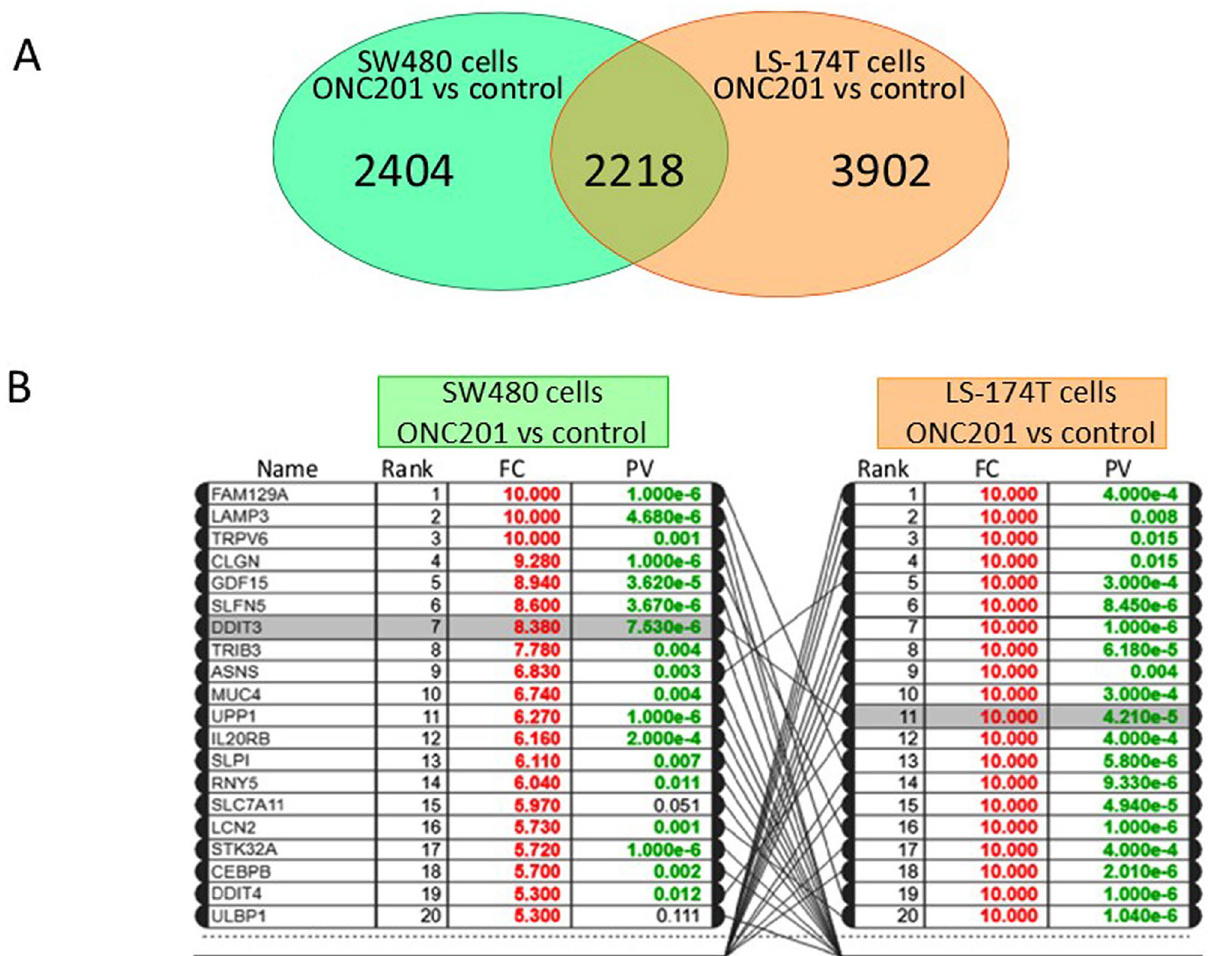
Figure 4. Meta-analysis Alignment of the differentially expressed common genes in response to ONC201 treatment. ( A ) A Venn diagram illustrating the total number of genes perturbed in response to ONC201 treatment in the nonmetastatic and metastatic cell lines. The overlapping areas indicate the numbers of genes that are commonly altered in both cell types. ( B ) Top ranked transcripts differentially regulated in LS-174T and SW480 cells in response to ONC201 treatment are shown, with significantly low p -values in green and fold expression in red